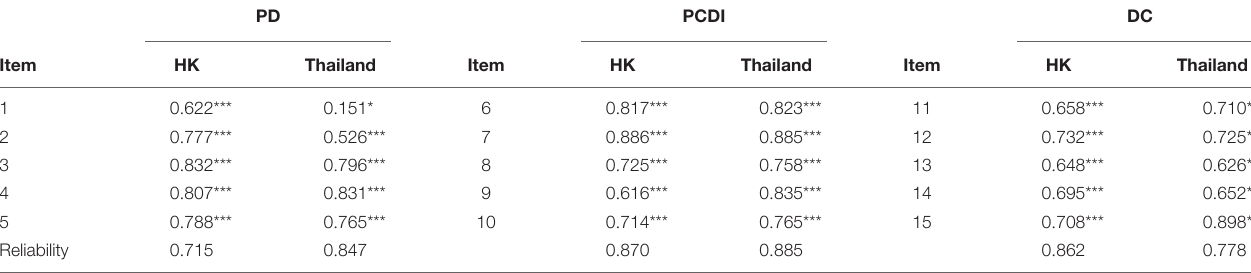
TABLE 2 | Standardized factor loadings and reliability of subscales for each culture.